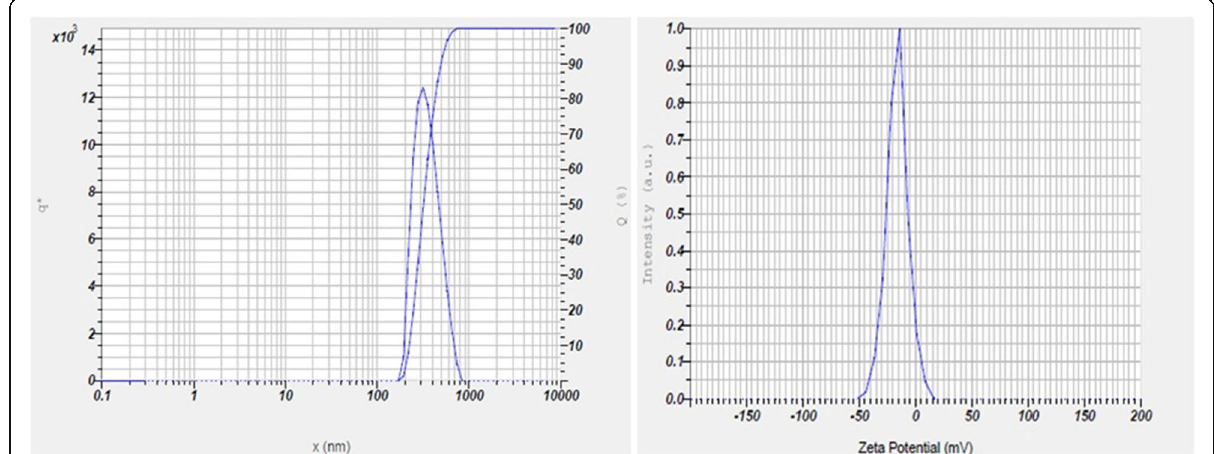
Fig. 3 Particle size analysis and Zeta potential of stabilized formulation by acid-base neutralization method after 90